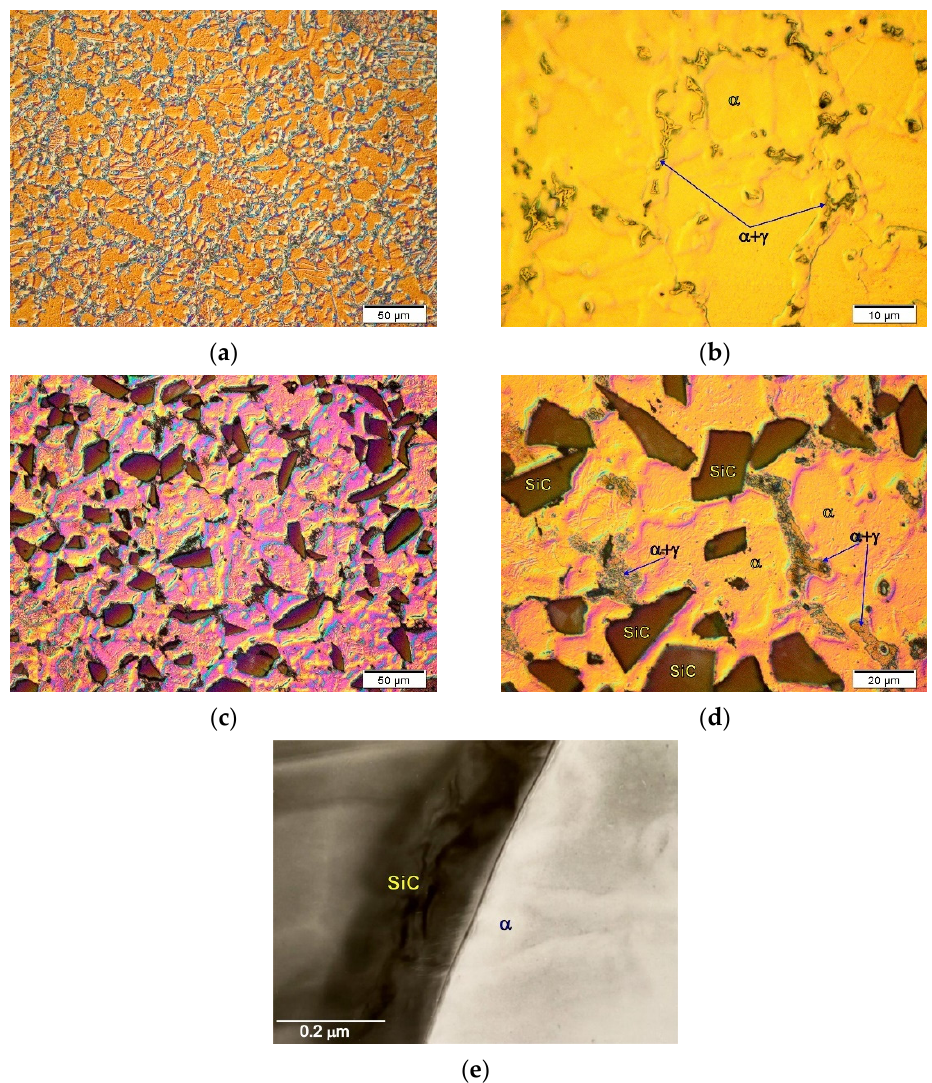
Figure 4. Microstructure of AM50 magnesium alloy. ( a , b ) Micrographs taken at different magnification) and microstructure of AM50 matrix composites with SiC particles. ( c , d ) Micrographs taken at different magnification; ( e ) TEM micrograph of interface between components.